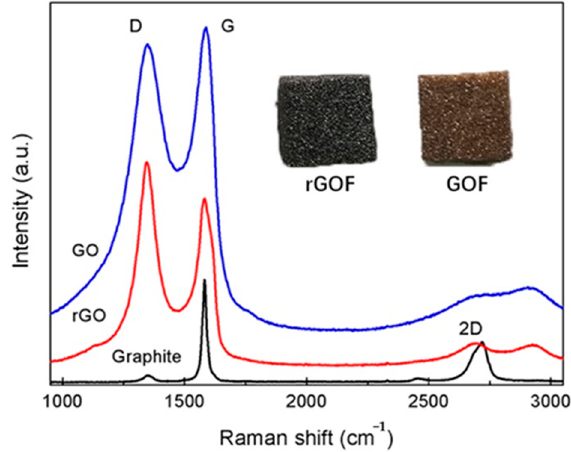
Figure 3. Raman spectra of natural graphite, GO and rGO and images of GOF and rGOF.